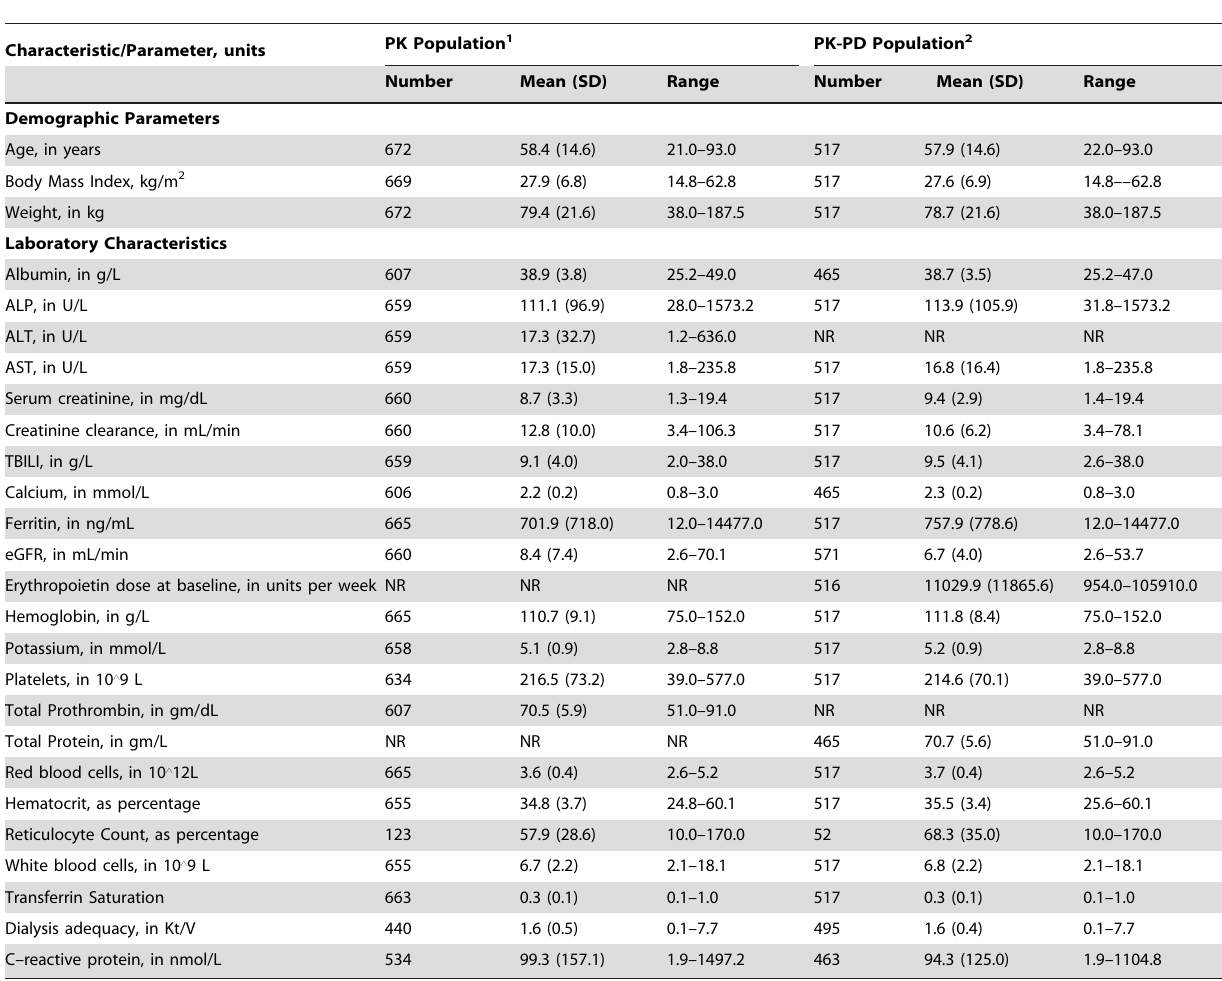
Table 3. Patient demographics and laboratory characteristics at baseline, by population